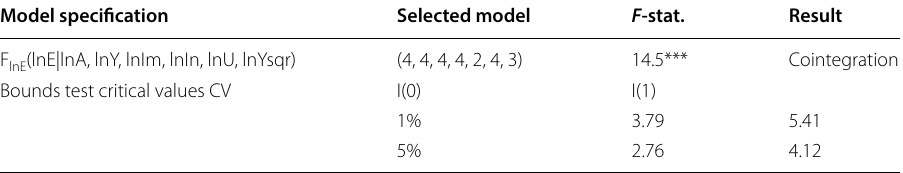
Statistically significant at 1% (***), 5% (**) and 10% (*) level